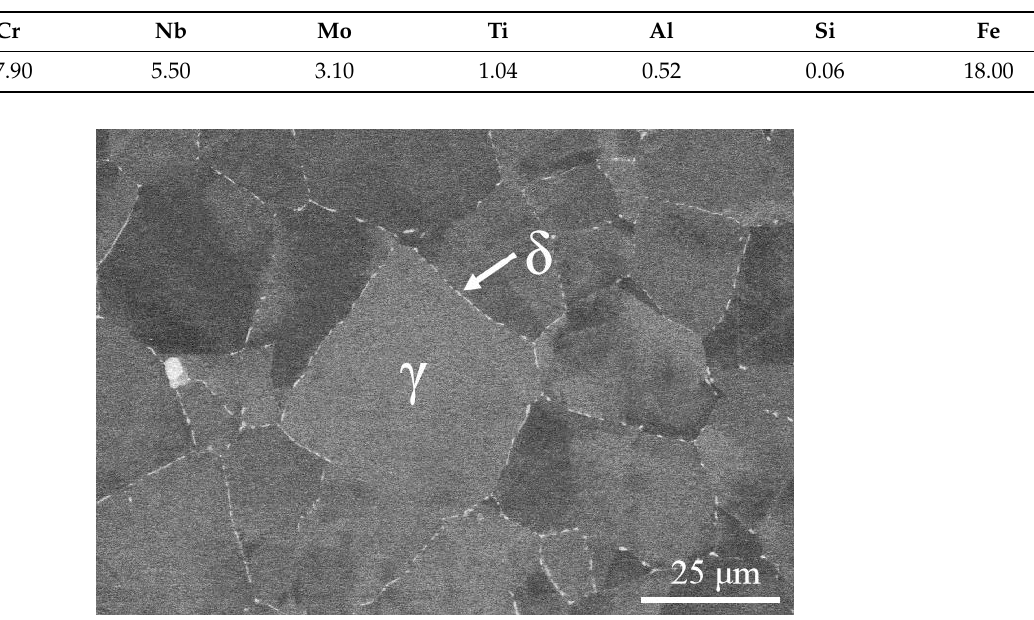
Table 1. Chemical composition of the GH4169 alloy.